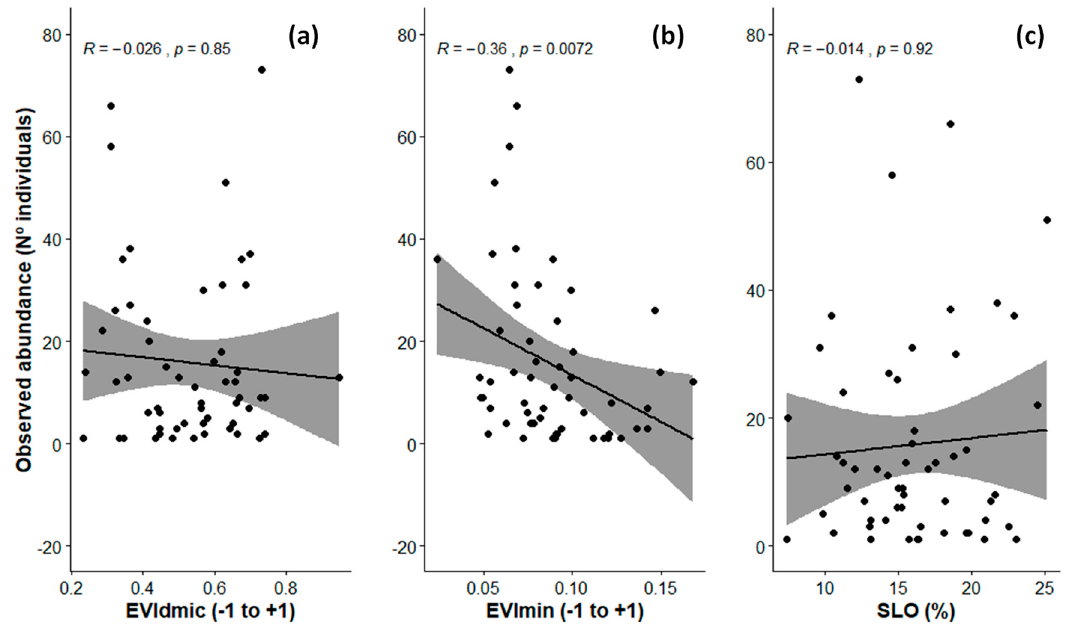
Figure 2. Relation between observed abundance (number of individuals) of Iris boissieri and each of the predictive variables included in the most parsimonious species abundance model (SAM) (Ecosystem functioning attributes (EFAs) + digital elevation model (DEM)); ( a ) cosine of the date of minimum enhanced vegetation index (EVI) (EVIdmic as minimum vegetation greenness); ( b ) EVI annual minimum (EVImin as indicator of minimum photosynthetic activity); ( c ) Slope (SLO as an indicator of terrain flatness). A significant Spearman correlation (R) was only found for the relationship between observed abundance and EVImin.